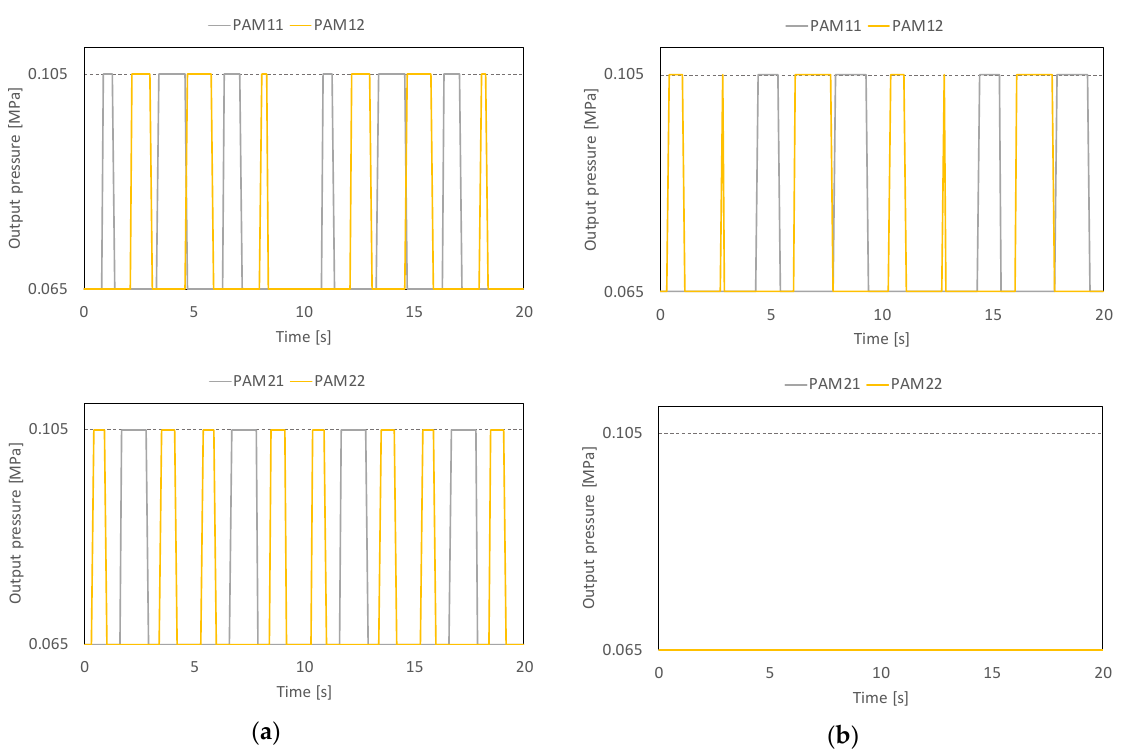
Figure 19. Cyclic inputs of PAMs using evaluation function 2 with 0.5 kg (( a ) first generation, ( b ) 18th generation).